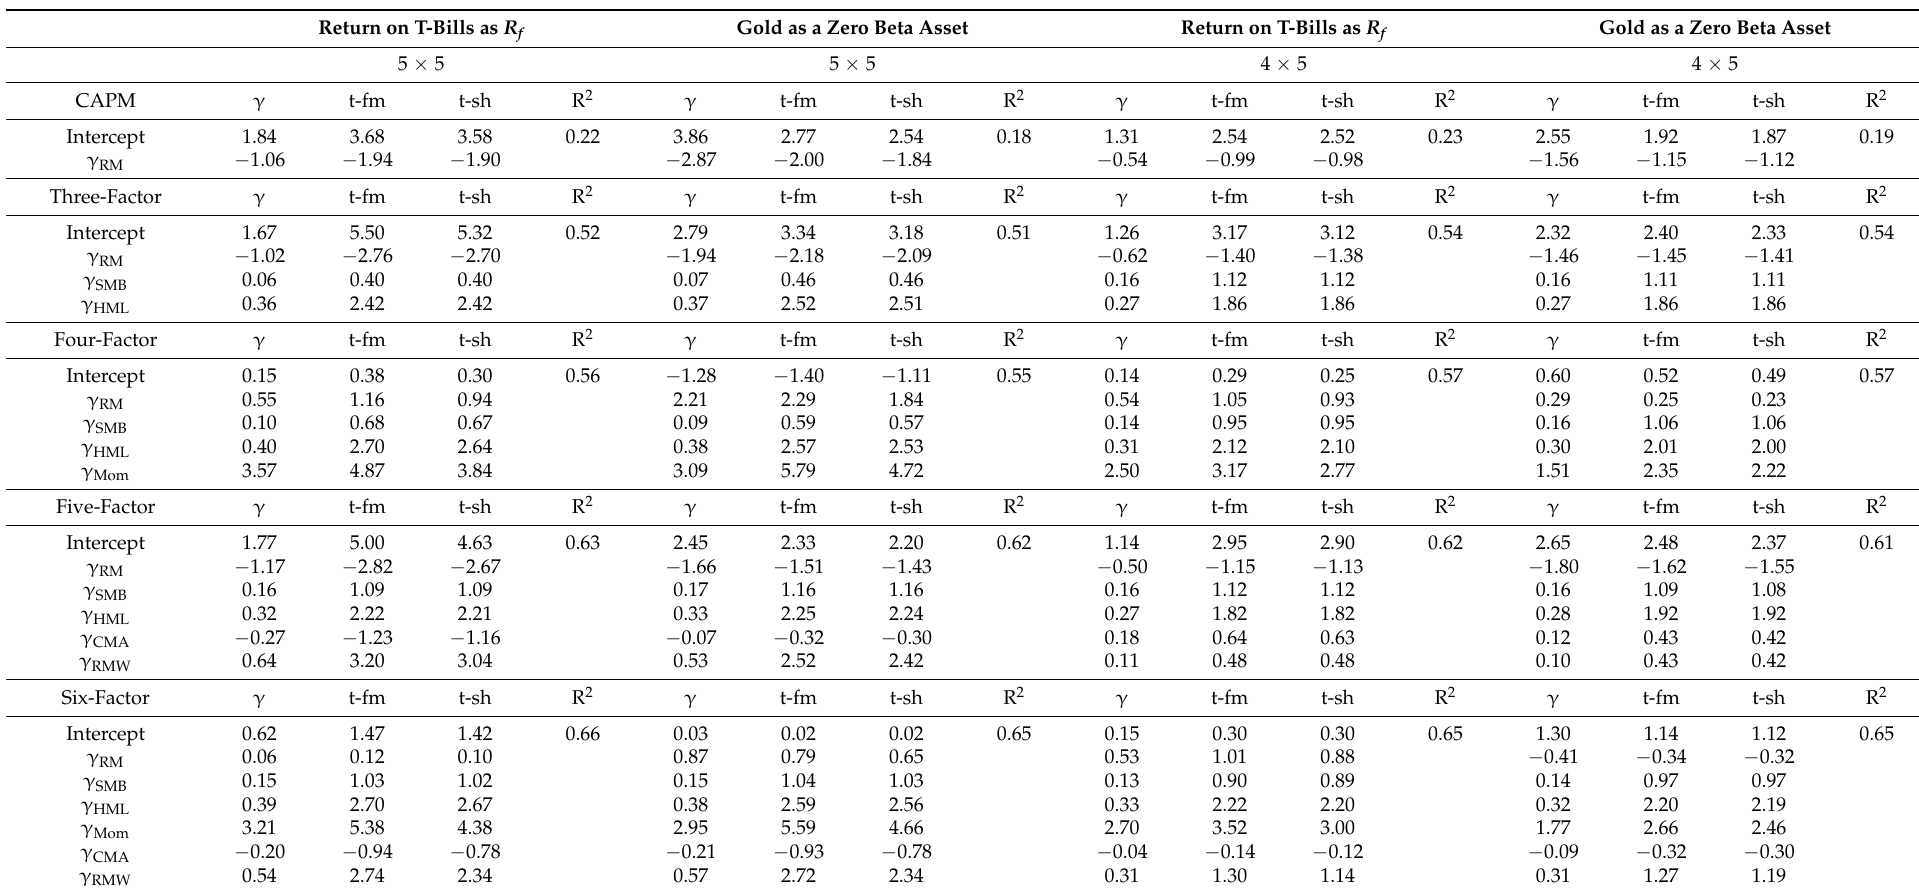
Table 10. Fama–MacBeth tests with 25 size and book-to-market portfolios with (5 × 5) and without microcaps (4 × 5) from January 1981–December 2015. Results represent monthly percent returns. The table reports average coefficients for the CAPM, three-factor, four-factor, five-factor, and six-factor models. The first and the third columns report results with return on Treasury bills as risk-free rate, whereas the second and fourth columns report results with gold as a zero-beta asset. γ is the average coefficient, t-fm is the t-statistic from the Fama–MacBeth procedure, t-sh is the Shanken (1992) error-in-variables corrected t-statistic, and R 2 is the average cross-sectional R-squared of the tested